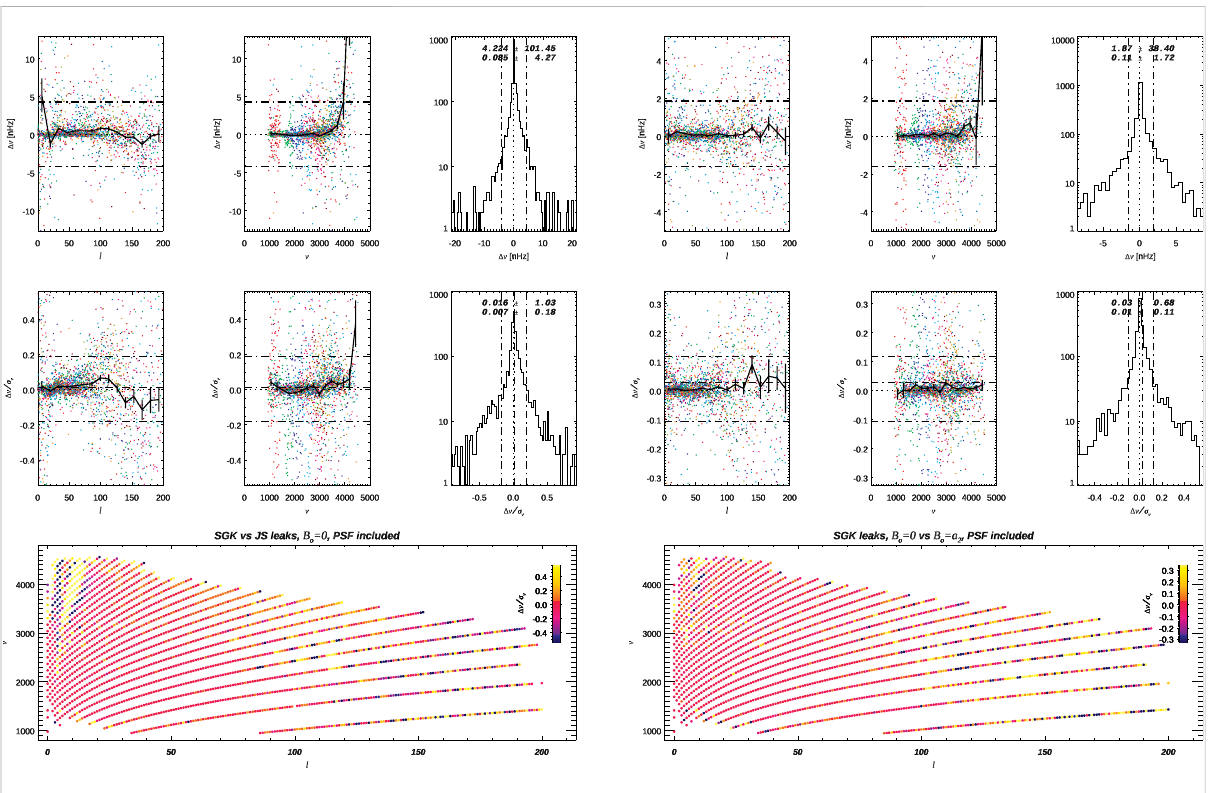
FIGURE 3 Comparison of multiplets ’ frequencies when fi tting using different leakagematrices. The seven panels on the leftcompare theresults using the JS B o (cid:3) 0leakagematrixtotheSGK B o (cid:3) 0leakagematrix,includingthePSF;thesevenpanelsontherightcomparetheresultsusingtheSGK B o (cid:3) a 2 leakage matrix to the SGK B o (cid:3) 0 leakage matrix, including the